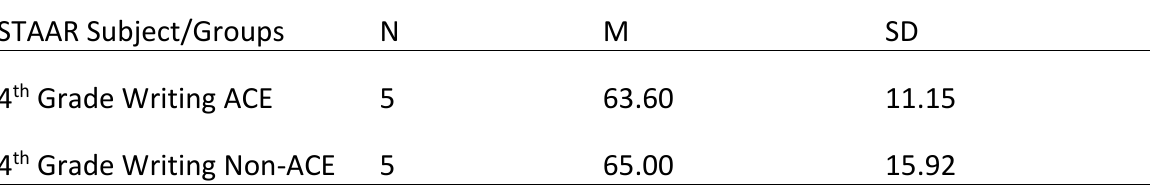
Table 6 : Means and Standard Deviations: Student performance in 4 th Grade STAAR Reading, Math, Writing